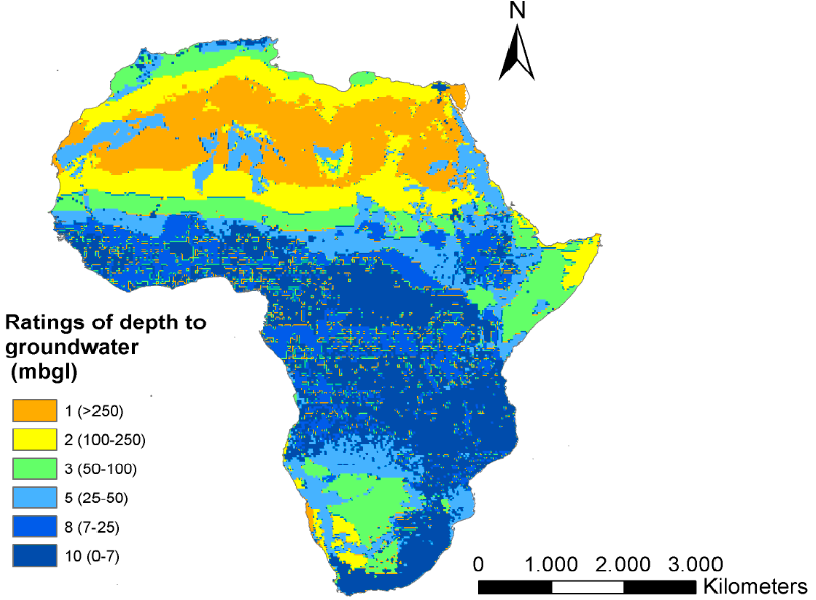
Figure 4. Depth to groundwater ( D ) rate map for Africa ([1]).